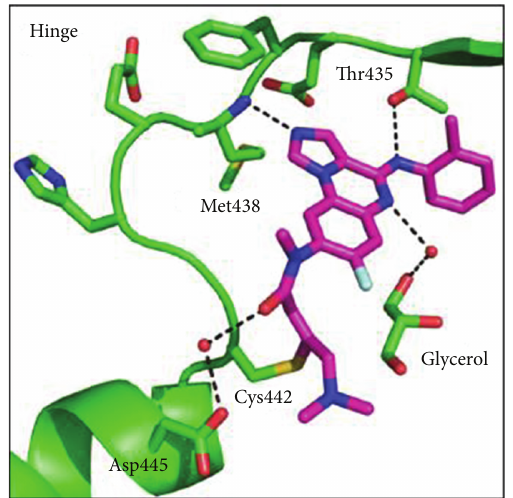
Figure 22: X-ray structure of 56 in complex with a gate-keeper variant of ITK enzyme in the ATP binding site.